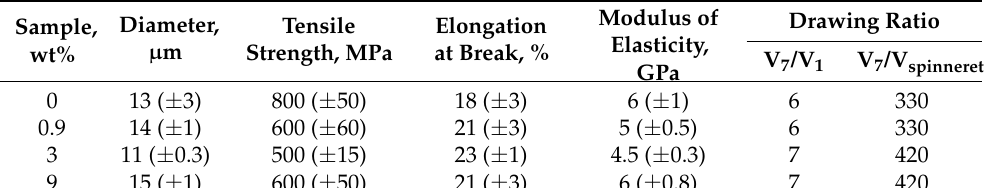
Table 3. Mechanical properties of fibers obtained from PAN solutions with silica by Mechanotropic spinning (at the polymer weight).